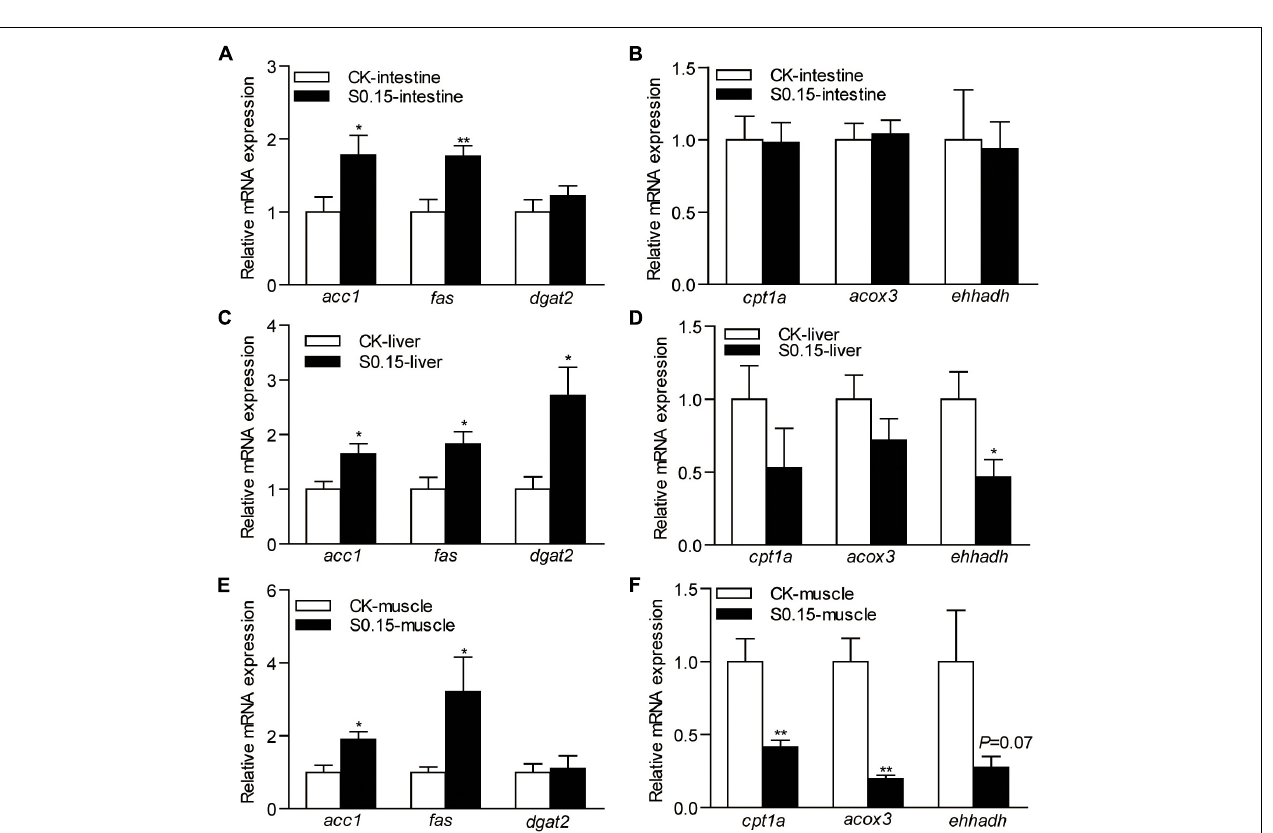
FIGURE 6 | The expression of lipid metabolism-related genes in zebrafish fed the CK or S0.15 diet for 4 weeks. (A) Lipid synthesis- and (B) lipid-degradation-related genes in the intestine. (C) Lipid synthesis- and (D) lipid-degradation-related genes in the liver. (E) Lipid synthesis- and (F) lipid-degradation-related genes in the muscle. Values are means ± SEMs ( n = 6 biological replicates). * p < 0.05, ** p < 0.01. CK, control-check diet; S0.15, 0.15% succinate-supplemented